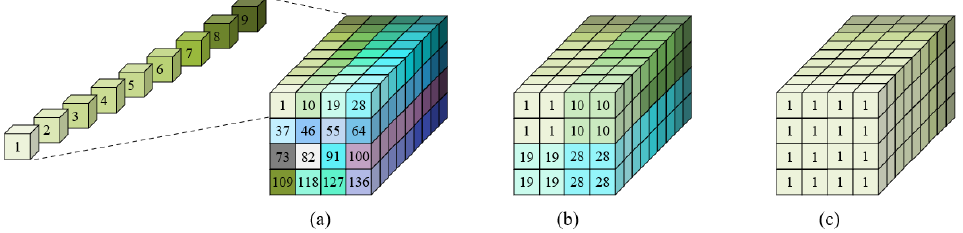
Figure 8. Data-mapping for 1 × 1 convolution. ( a ) Case for 4-bit, which completes 144 convolutions in total at a time with 100% utilization and each cube finishes one 1 × 1 convolution. ( b ) Case for 8-bit, which completes 36 convolutions in total at a time with utilization 100%. ( c ) Case for 16-bit, which completes 9 convolutions in total at a time with utilization